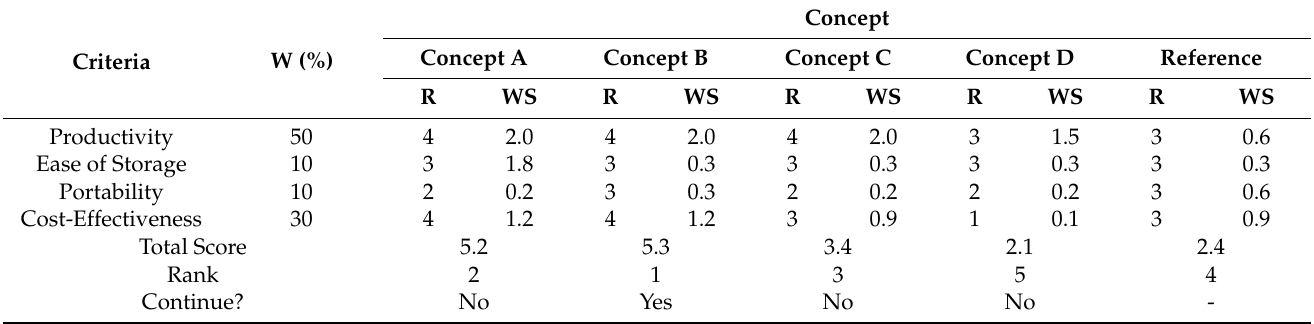
Table 7. Scoring of the